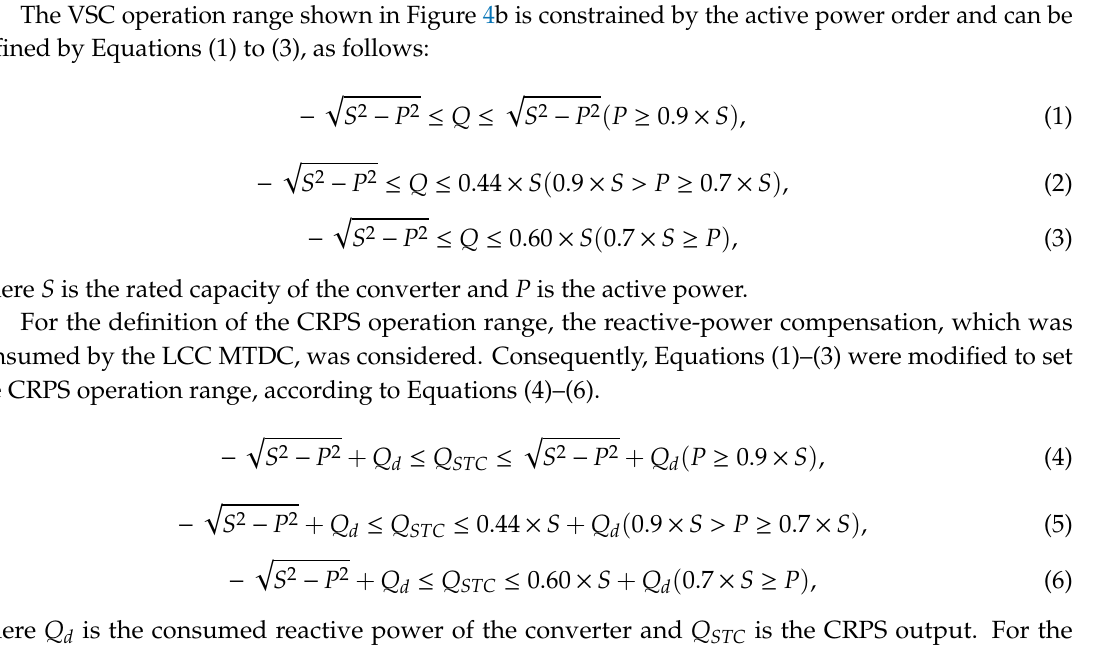
Figure 4. VSC operation range limitation: ( a ) Sample of actual operation limitation; ( b ) simplified operation limitation.